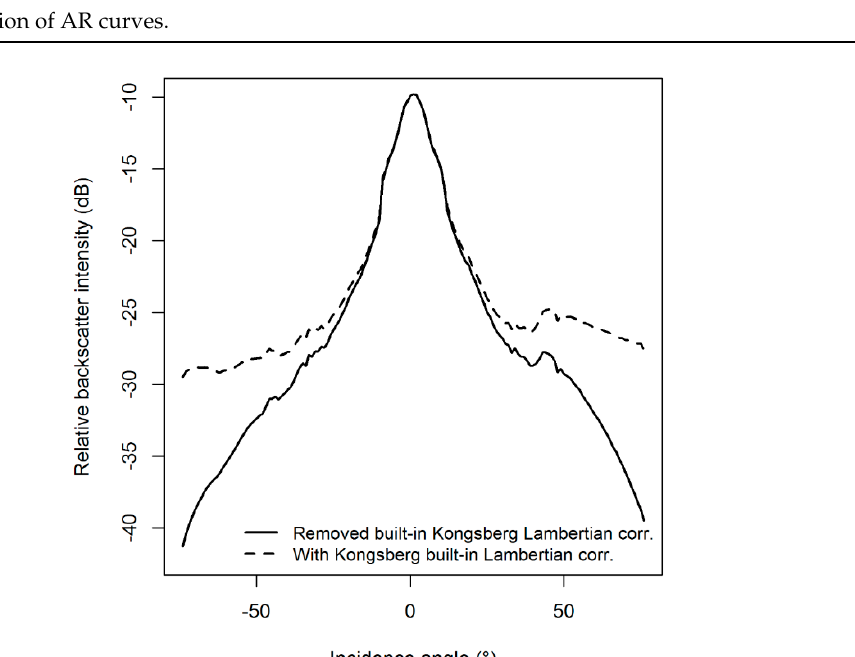
Figure 4. Illustration of the difference between angular response curves provided by the Kongsberg manufacturer after correction in SonarScope © to remove the specular correction (dashed line, applied by default in SonarScope © processing routine) and the Lambertian correction (solid line, backscatter status 1 in SonarScope ©). The solid line is the type of angular response data used in the present investigation and is believed to be the best estimate of the raw intrinsic seafloor backscatter response. The type of BS data output particularly suits the study of variability (i.e., relying on an artefact- and bias-free dataset) since the built-in specular-adaptive and Lambertian corrections are computed on a ping-to-ping basis, hence possibly introducing biases due to the local seafloor configuration.